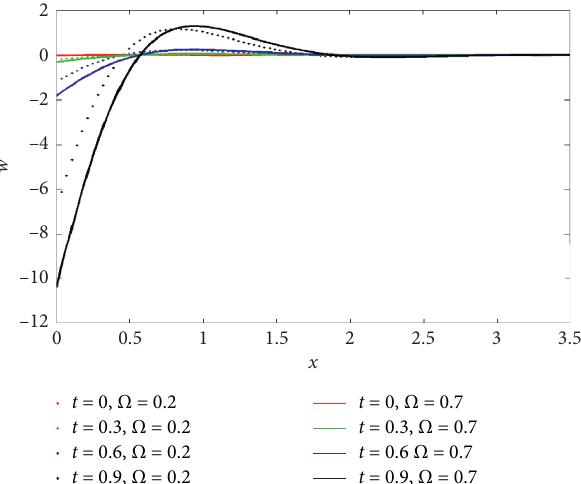
Figure 22: Stress σ